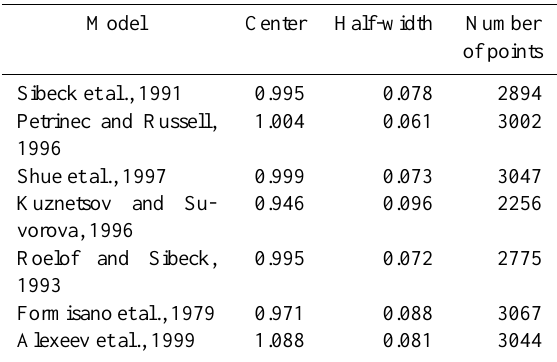
Table 4. Comparison of models in solar wind aligned